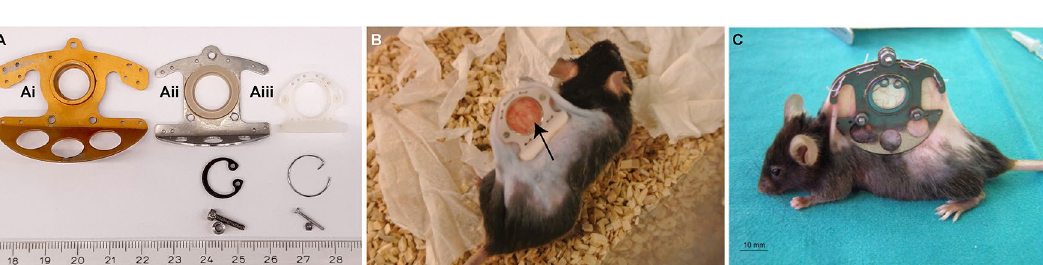
Figure 5. Whole-mount staining procedure. ( A ) Top view of the mouse, fixated chamber with a B16BL6 tumor 13 days after implantation on the chamber holder and chamber-to-stage platform. ( B ) After killing the animal the window is removed from the back of the animal. ( C ) Tissue without the window frames. ( D ) Excess skin removed leaving 5 mm tissue from the window view area intact. ( E ) Excess skin removed while leaving a piece of skin for easy handling (forceps position). ( F ) Staining of the tumor tissue in a 24 wells plate. ( G ) Mounting of tumor tissue using glycerol in an imaging chamber.